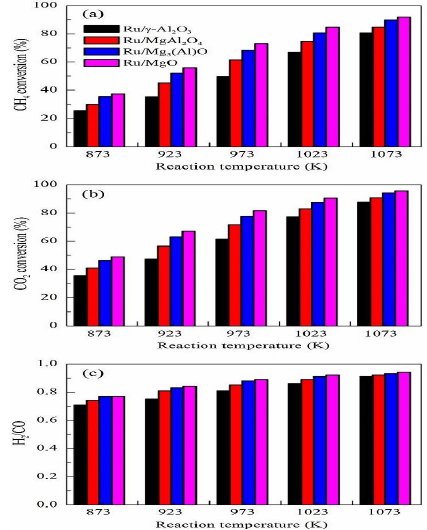
Figure 4. Catalytic performance of Ru-based catalysts impregnated on different supports for DRM at different reaction temperatures: ( a ) CH 4 conversion; ( b ) CO 2 conversion; and ( c ) H 2 /CO ratio. Reaction conditions: CH 4 :CO 2 :N 2 = 1:1:2, WHSV = 60,000 mL g − 1 h − 1 ; reaction time, 1 h at each